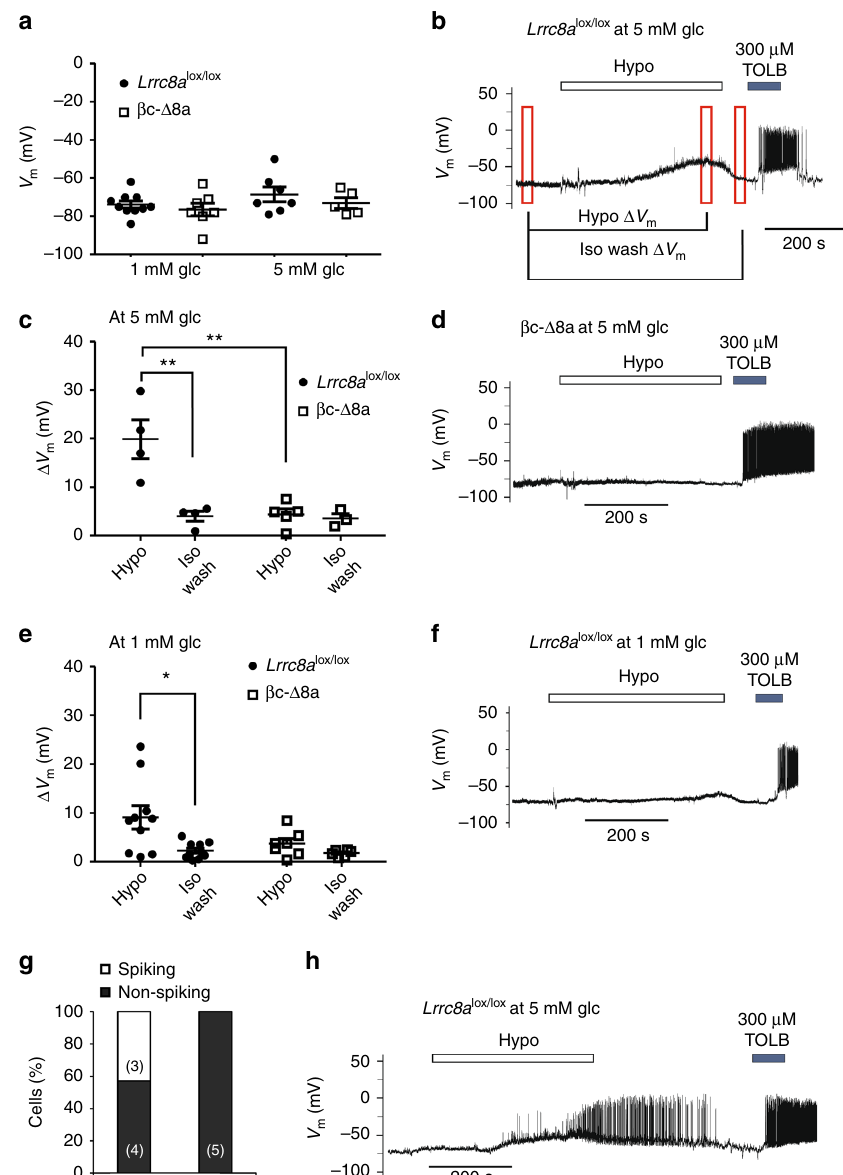
Fig. 4 Hypotonicity-induced depolarization of β -cells. Gramicidin-perforated patch-clamp recordings of primary mouse β -cells. a Resting membrane potential of control Lrrc8a lox/lox or β c- Δ 8a β -cells at 1 or 5 mM glucose concentrations. Mean values ± SEM indicated by error bars. b Representative trace for hypotonicity-induced depolarization of the membrane potential V m in control Lrrc8a lox/lox animals at 5 mM glucose. TOLB, tolbutamide. c Δ V m after applying hypotonicity, or following washout with isotonic solution of Lrrc8a lox/lox or β c- Δ 8a cells at 5 mM glucose, calculated from data as indicated in b . Spiking cells (see g and h ) were excluded from analysis. d Representative voltage trace showing lack of hypotonicity-induced depolarization of β c- Δ 8a β - cells at 5 mM glucose. e Δ V m of Lrrc8a lox/lox or β c- Δ 8a cells as in c , but at 1 mM glucose. f Representative trace for Lrrc8a lox/lox β -cells challenged